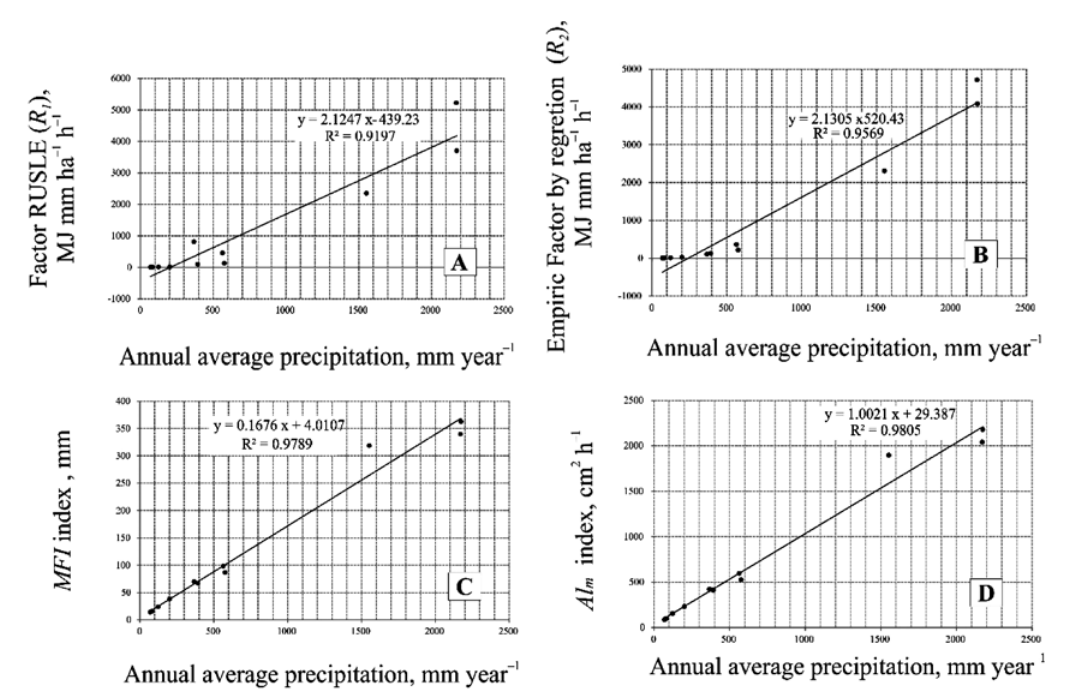
Fig. 5. Linear regression of annual average precipitation ( P ) in mm with respect to indicators of erosivity: (A) R in MJ mm ha –1 h –1 , (B) R in MJ mm ha –1 h –1 , (C) MFI index in mm and (D) AI 1 2 northwestern